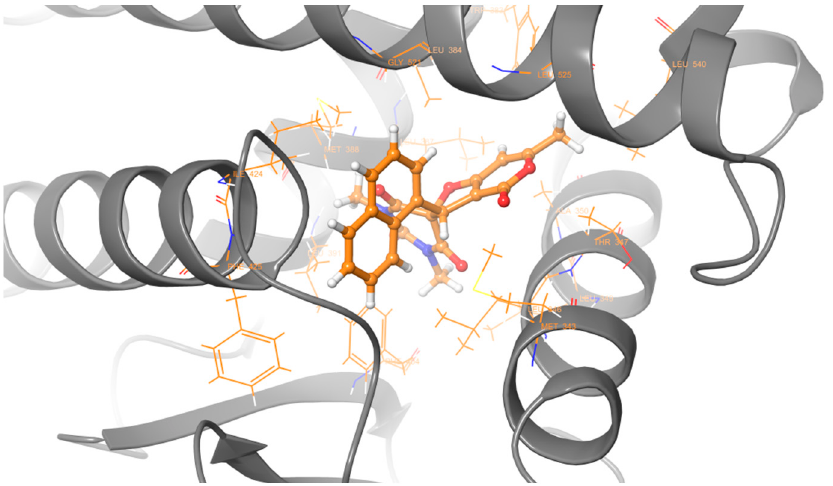
Figure 2. Compound 2i docked into estrogen receptor (4iw8).